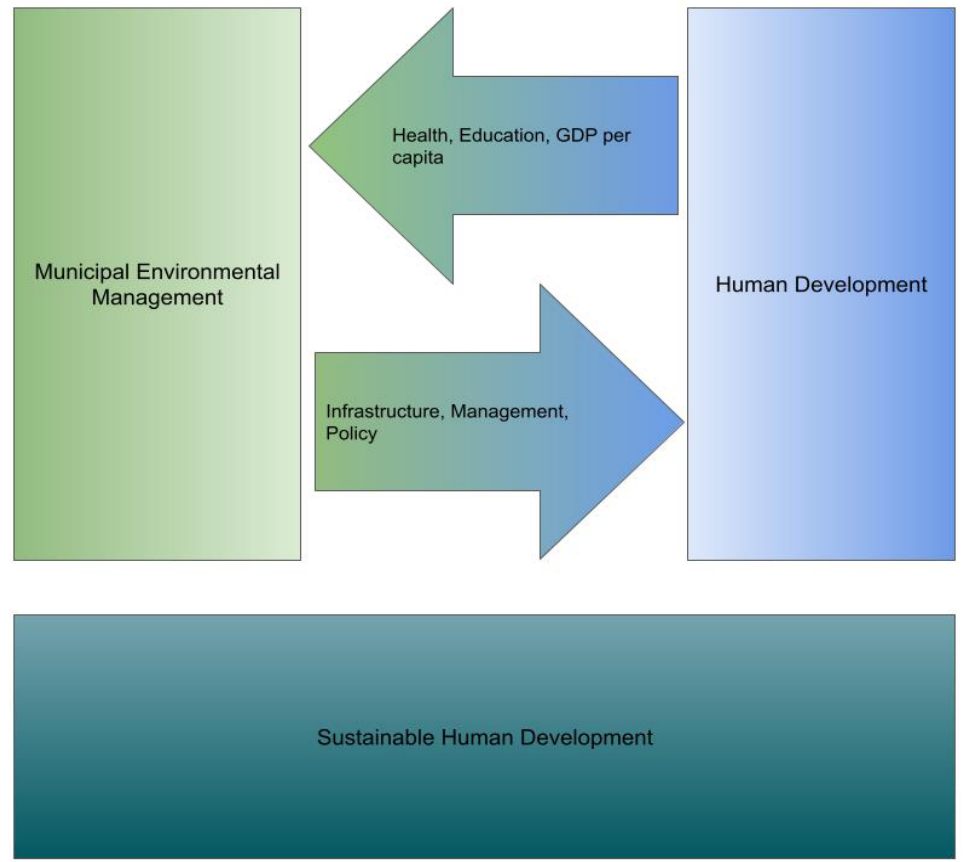
Figure 1. Conceptual framework.